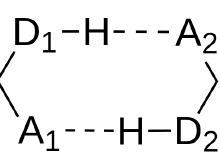
Figure 3. Hydrogen bond connectivity pattern involved in the formation of the dimers. A and D stand for the acceptor and donor HB moieties,